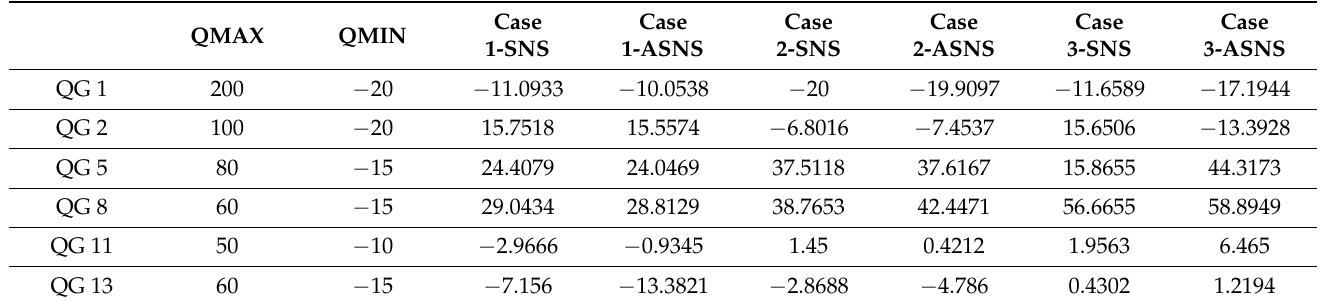
Table A2. Generators’ reactive power for the IEEE 30-bus system.